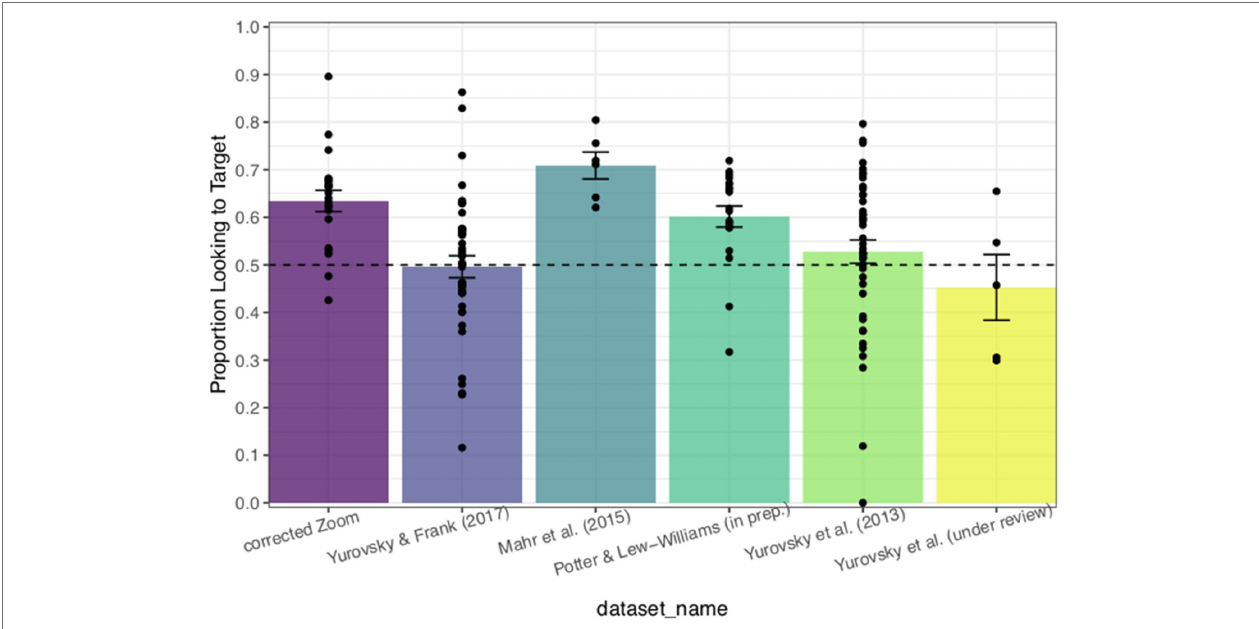
FIGURE 4 | Proportion of looks to the target (accuracy) by study, comparing Study 1 to selected Peekbank studies. Chance looking behavior is denoted by the dashed line at 0.5 on the y -axis. Error bars represent